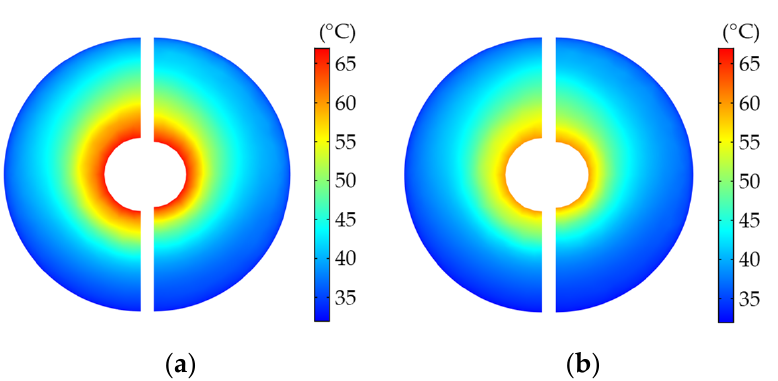
Figure 9. Surface temperature distribution of the spacer with different SF 6 pressures. ( a ) 0.4 MPa, ( b ) 0.6